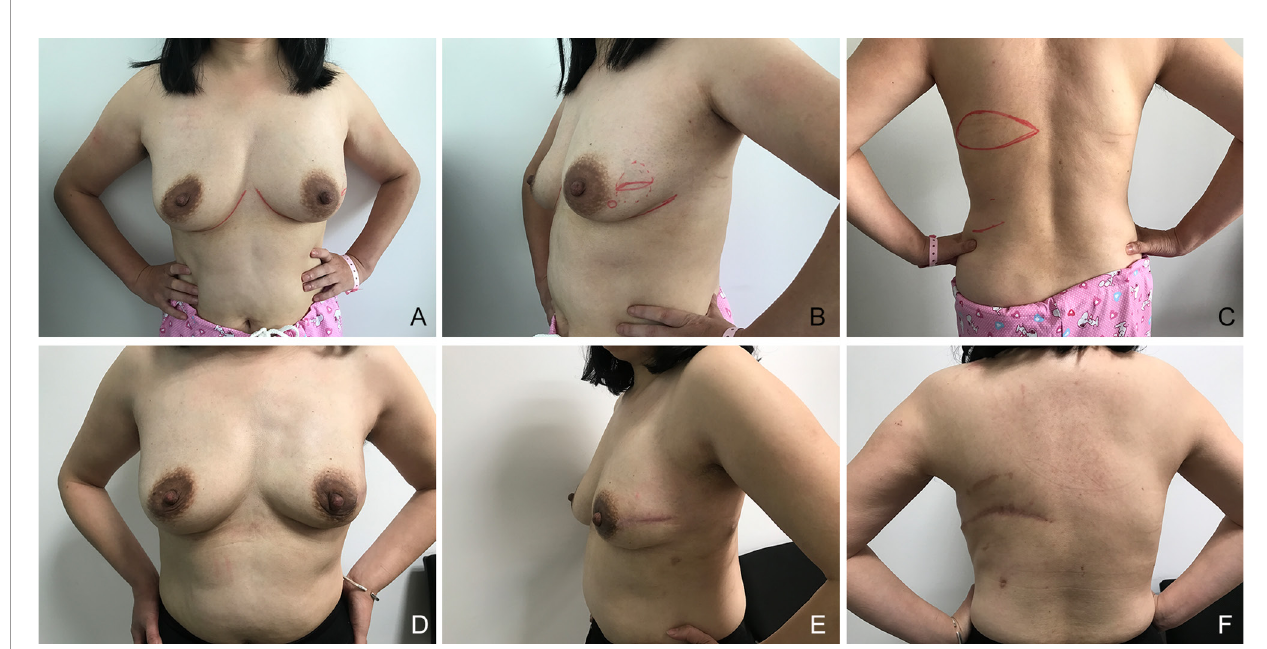
FIGURE 2 | Images of a 50-year-old patient, which were obtained 1 year after left breast nipple-sparing mastectomy with whole latissimus dorsi muscle fl ap (MWLD) for breast reconstruction. (A) Frontal view before surgery; (B) lateral view before surgery; (C) back view before surgery; (D) frontal view after surgery; (E) lateral view after surgery; (F) back view after surgery.